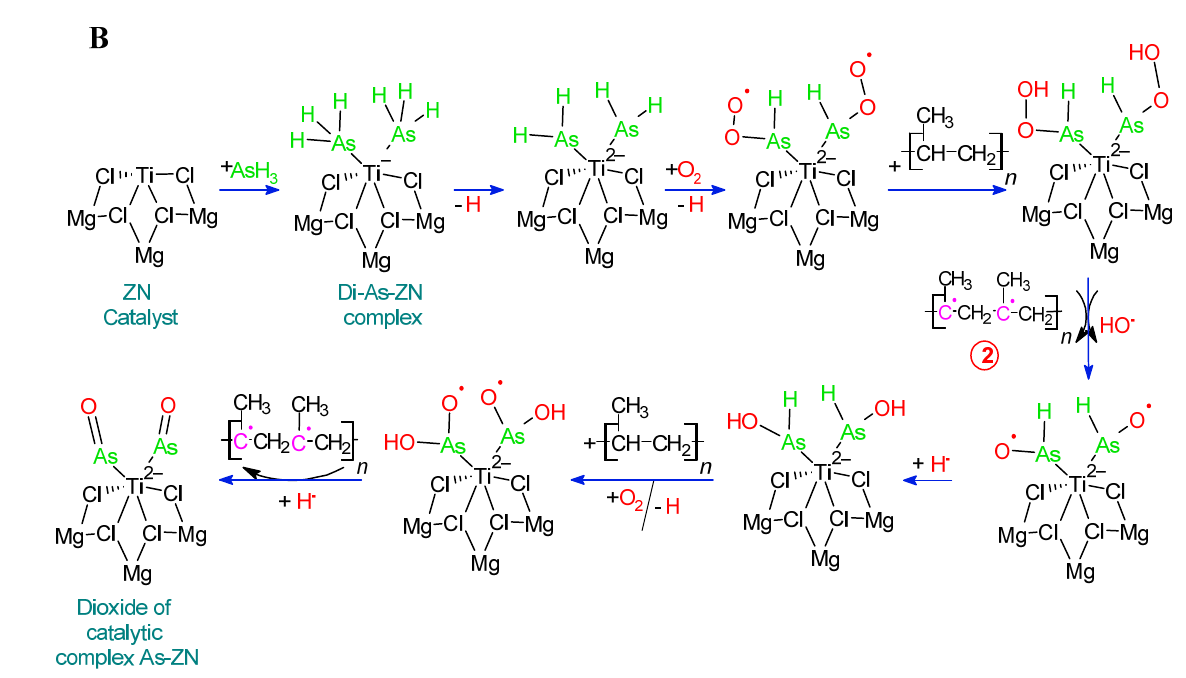
Figure 3. Reaction mechanism of residual AsH 3 with TiCl 4 /MgCl 2.